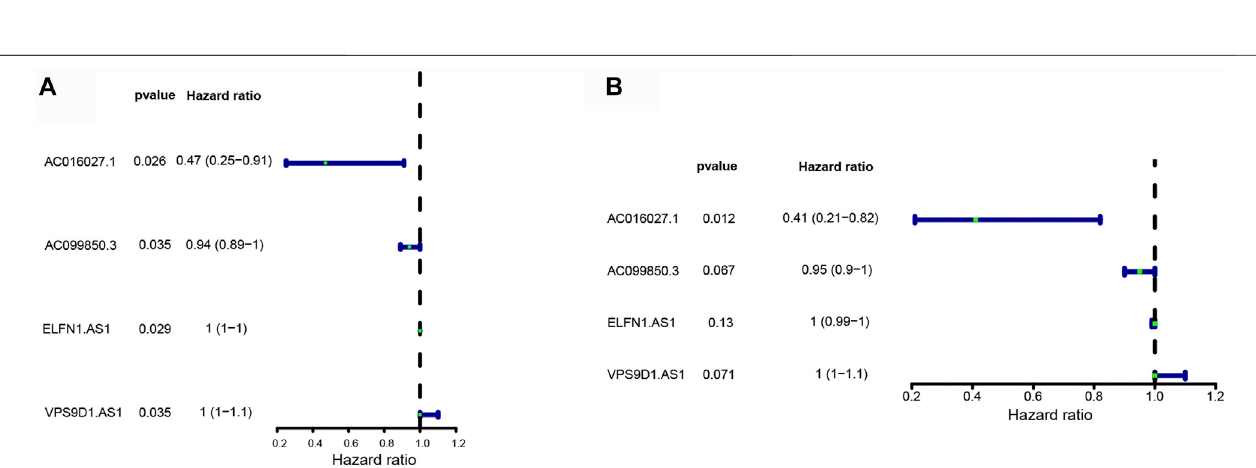
FIGURE 3 | Construction of ferroptosis-related lncRNA prognostic signature in CRC patients. (A) Forest plots showed 4 DE-FLs selected by the univariate Cox regression. (B) Forest plots showed four prognostic DE-FLs identi fi ed by the multivariate Cox regression.